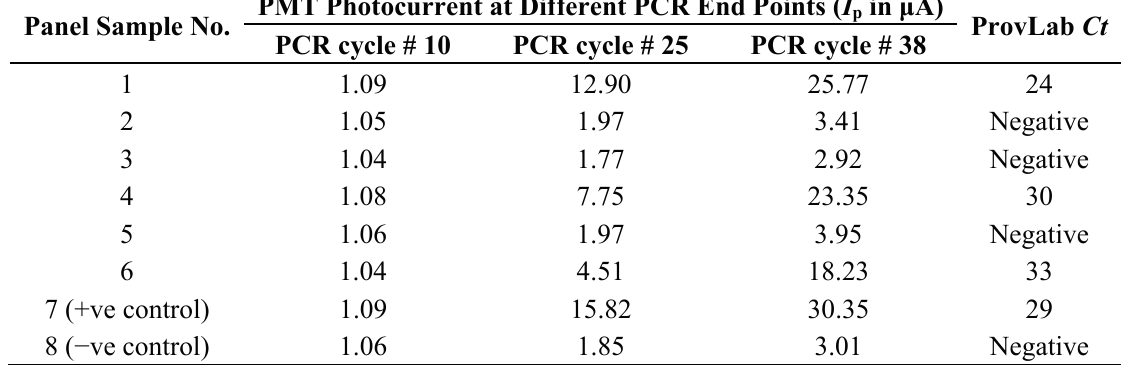
Figure 5. Charge-coupled device (CCD) images showing the outcomes (fluorescent intensity) of the end-point PCR assay carried out using panel samples of Table 1a. Table 2. Outcomes of the end-point panel polymerase chain reaction (PCR) using samples from Table 1a. Panel Sample